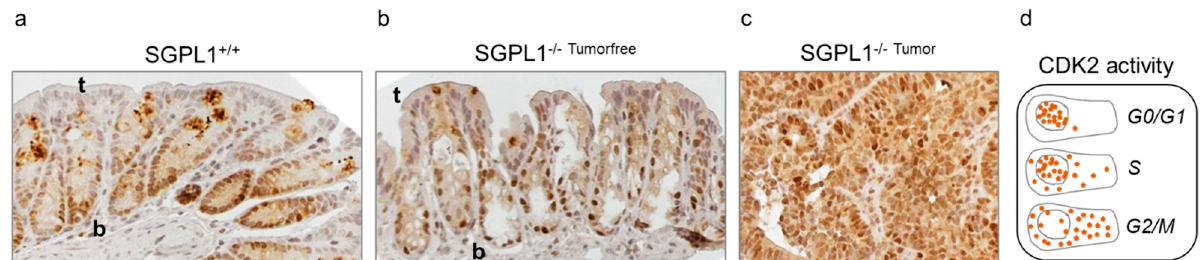
Figure 4. Anti-CDK2 staining ( n = 5) of ( a ) wildtype (SGPL +/+ ) and ( b ) SGPL1 knockout (SGPL − / − ) colon sections and ( c ) SGPL1 knockout colon tumor sections after CAC induction (9 weeks); (magnification 40×). ( d ) Overview of CDK2 protein distribution during cell phases (scheme on the basis of [17]); CAC = colitis associated colon cancer; in image: t = Crypt tip; b = crypt bottom.